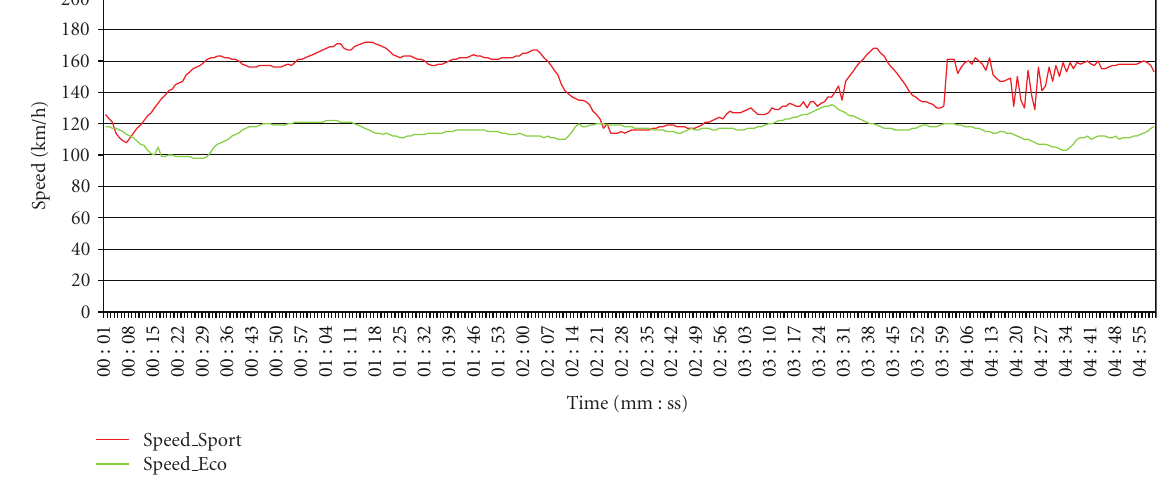
Figure 1: Recorded speed data of sporty and ecological driving over a time of 5